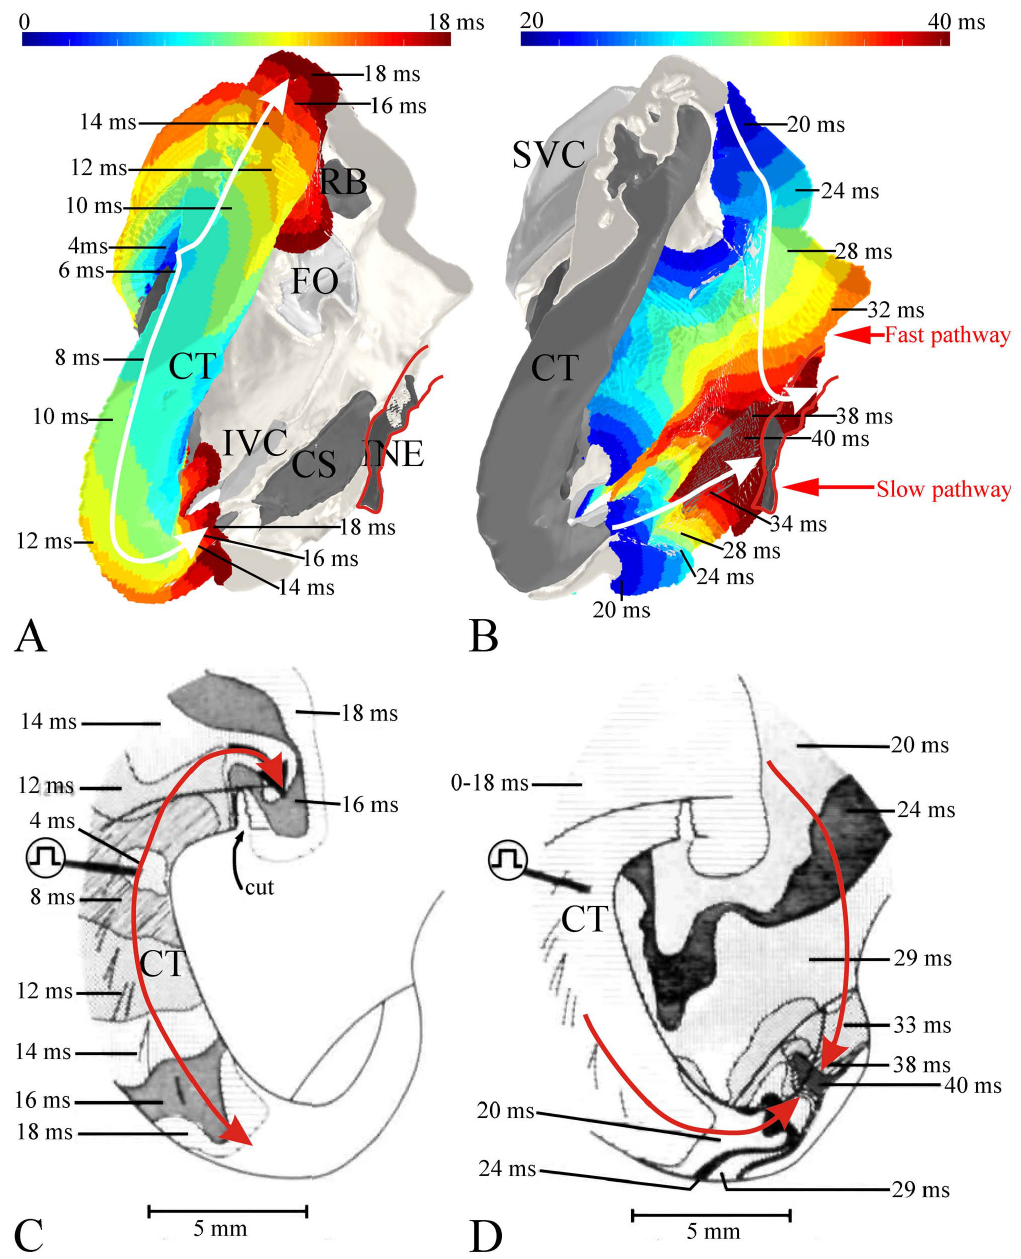
Figure 6. Action potential conduction from the SAN to the AVN. A and B, simulation of action potential conduction from the SAN to the AVN in the model of the right atrium during sinus rhythm (A, early times; B, later times). Internal right view of the model shown. Anatomical structures are shown in grey scale. The activation sequence is shown by a colour scale and the arrows show the direction of action potential conduction. Activation times are relative to the arrival of the action potential at the crista terminalis from the SAN. C and D, equivalent experimental data for the rabbit right atrium from Spach et al. [72]. In the experiment, the crista terminalis was stimulated close to the site where the action potential is expected to arrive first from the SAN. CN, compact node; CS, coronary sinus; CT, crista terminalis; FO, fossa ovalis; INE, inferior nodal extension; IVC, inferior vena cava; PB, penetrating bundle; RB, roof bundle; SVC, superior vena cava.